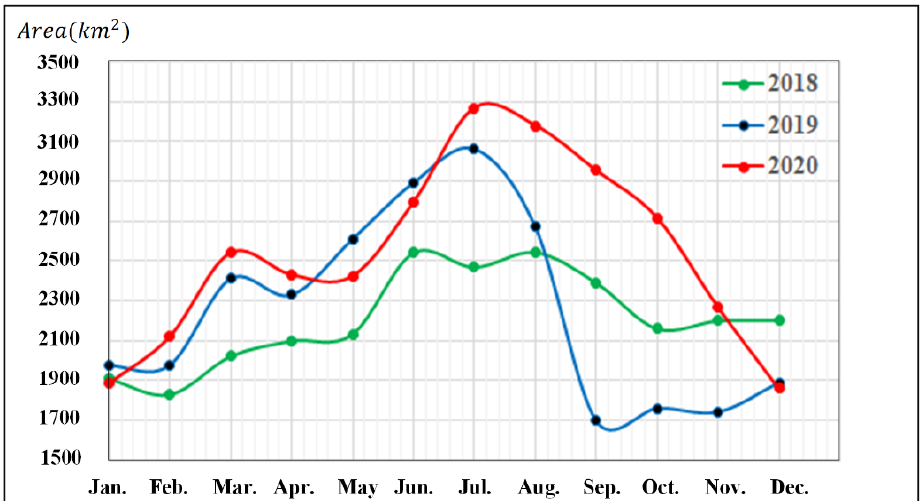
Figure 14. Monthly water area statistics of Dongting Lake from 2018 to 2020.